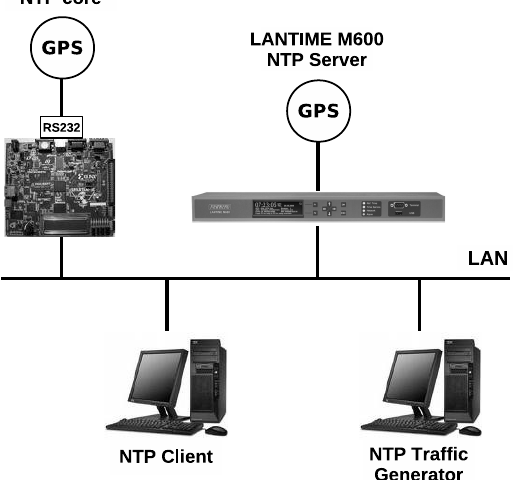
Figure 18. Testing set-up showing connections between NTP clients and servers.